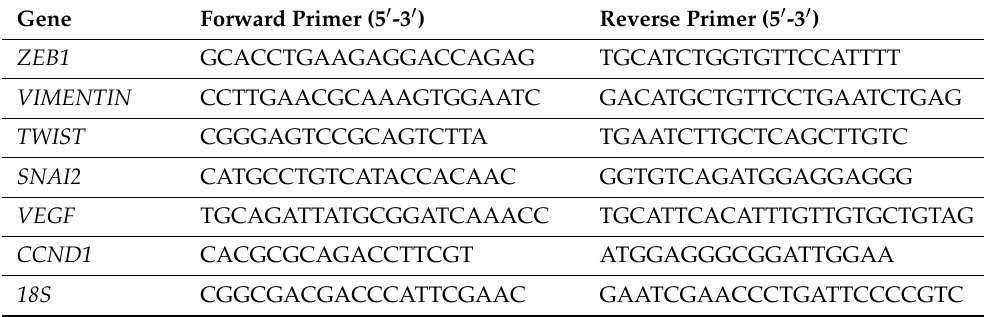
Table 1. QPCR primers